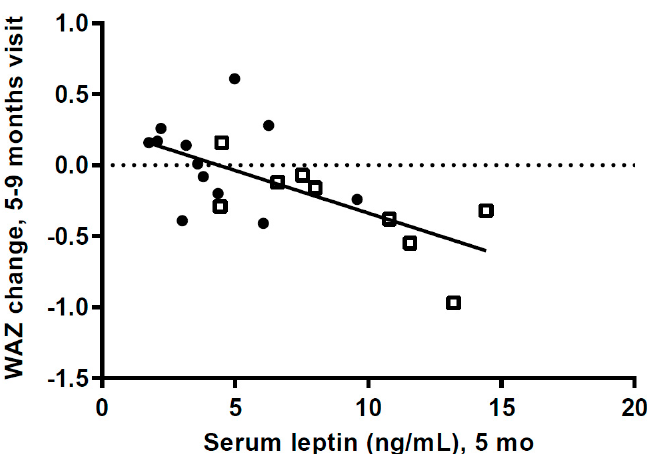
Figure 5. Scatterplot of change in weight-for-age z -scores from 5 months visit to 9 months visit versus serum leptin concentration at 5 months ( p = 0.0015), ( n = 9 in high weight gain group (HW); n = 12 in normal weight gain group (NW); WAZ: weight-for-age z -scores. HW = □ NW = ● Regression for HW group ( p = 0.031); for NW group ( p = 0.404).